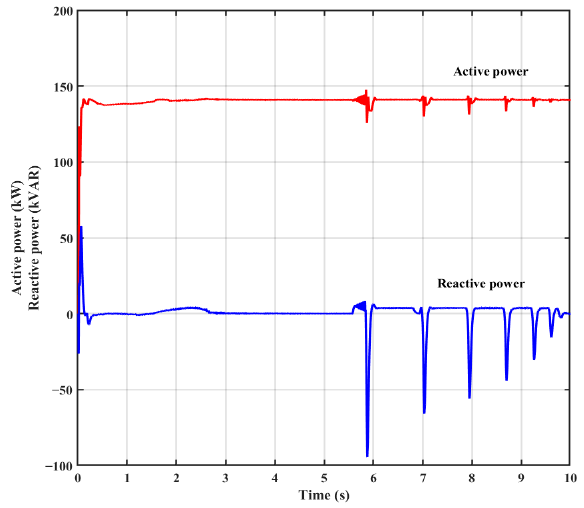
Figure 17. The power output of the small PV farm.